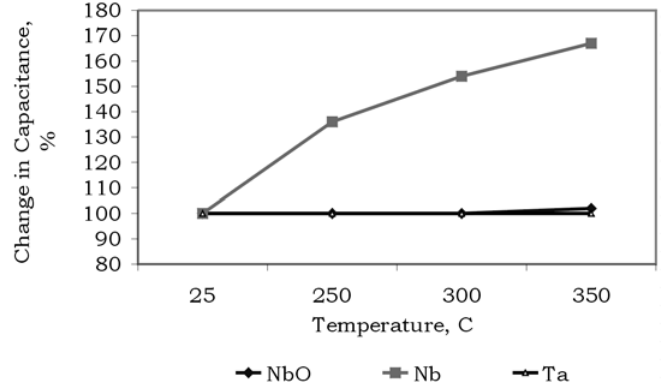
FIGURE 6 Ta, Nb, and NbO anodes during annealing.